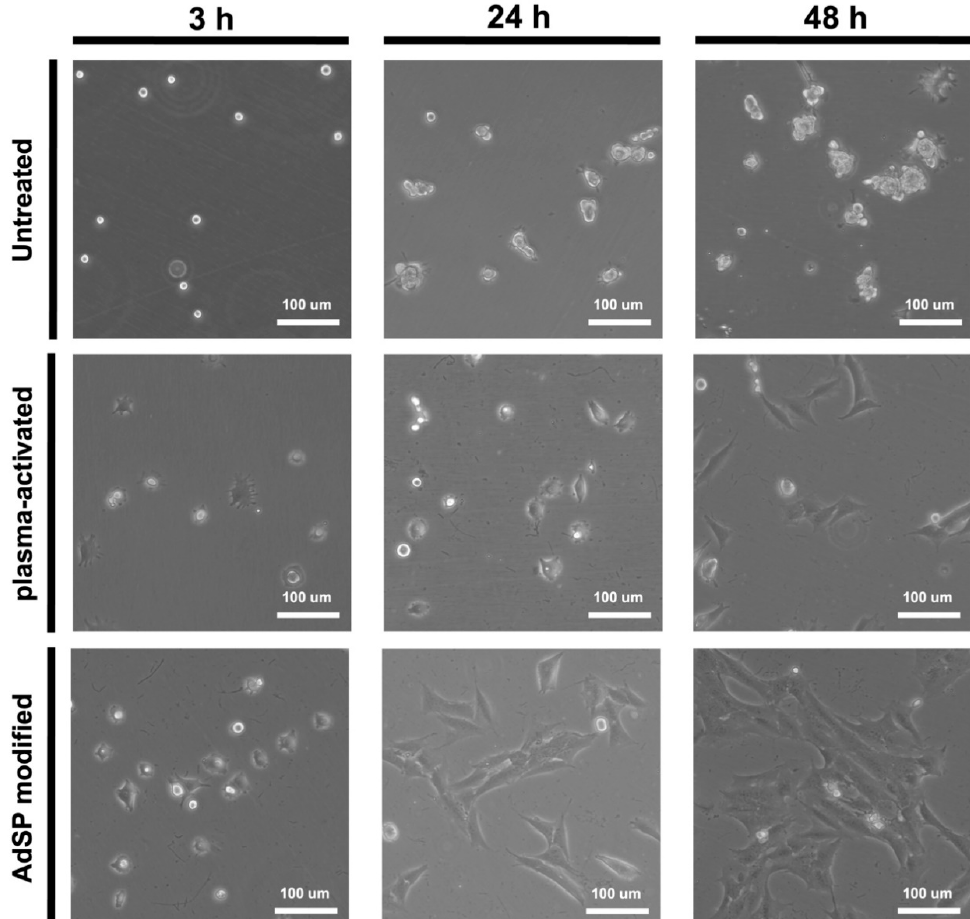
Figure 7. Cell adhesion behavior of NSCs within 48 h on the untreated non-adhesive dish, the plasma-activated dish, and the AdSP-modified dish.